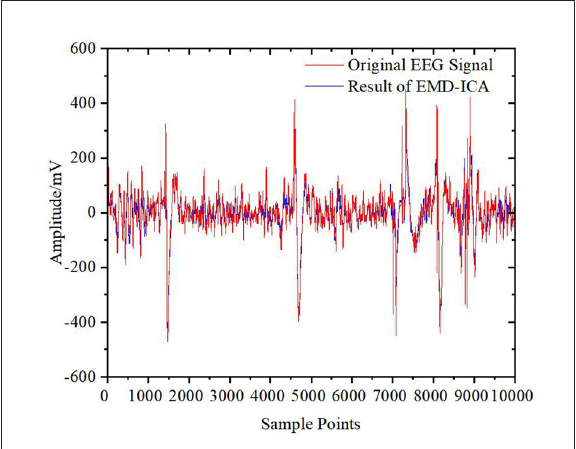
FIGURE13 Original signal and EMD-ICA algorithm signal.